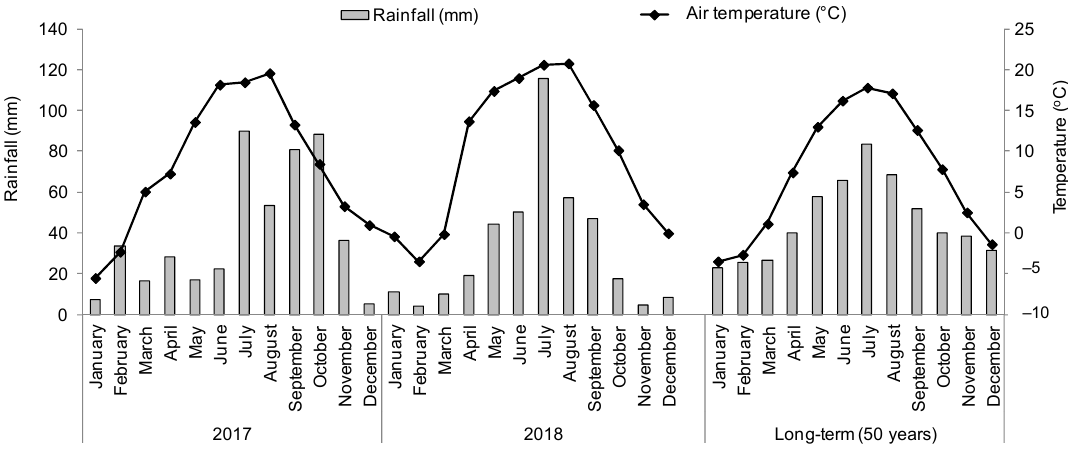
Figure 1. Weather conditions during 2017–2018 and long-term averages for the study site.